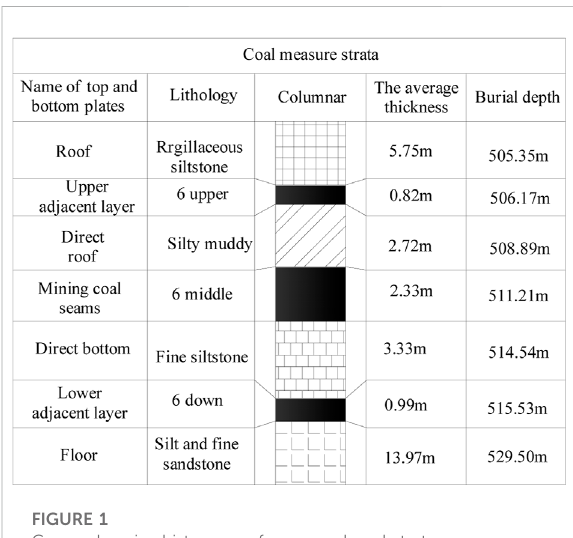
FIGURE 1 Comprehensive histogram of measured coal